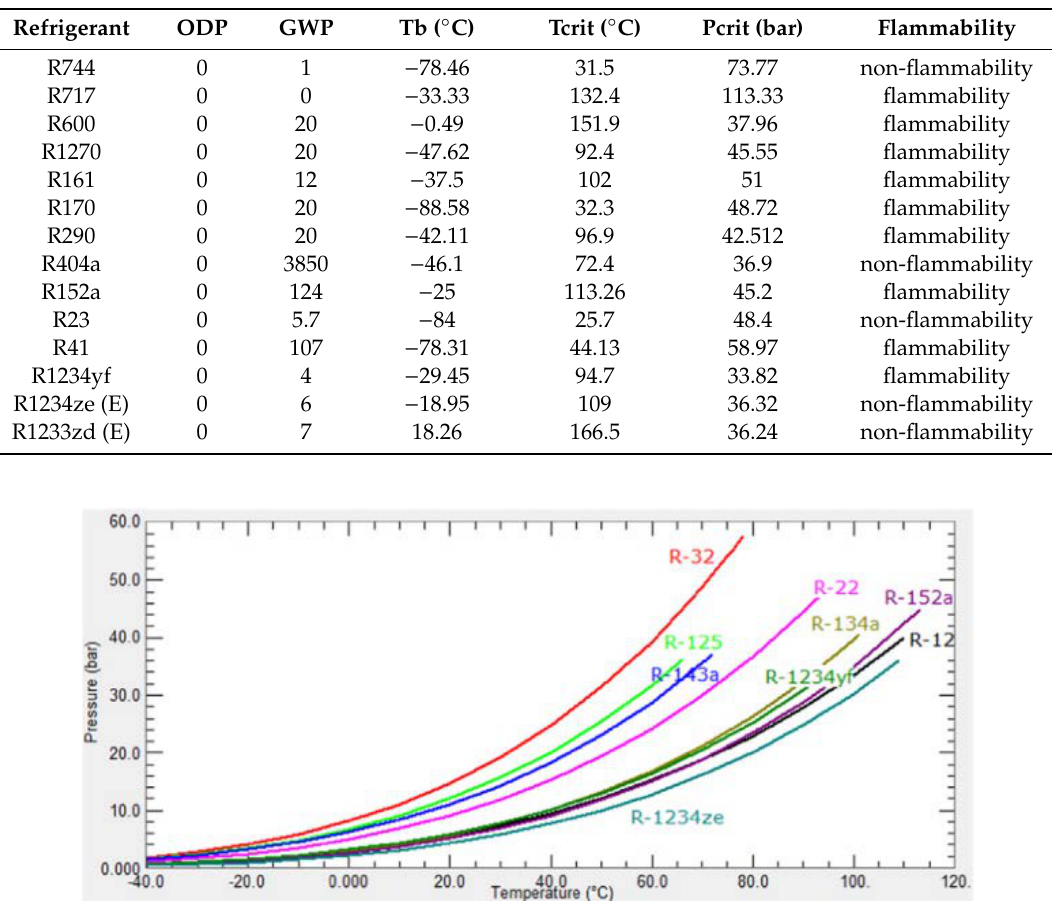
Table 3. HFC/HFO Mixtures composition by mass percentage [43]. Reproduced with permission from [Elsevier], Elsevier, 2020.